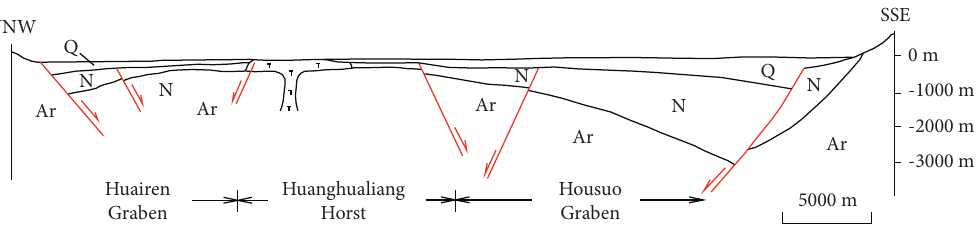
Figure 4: Geological section diagram of new rift of the Sanggan River, which contains Huairen Graben, Huanghualiang Horst, and Housou Graben, illustrating the geological structures of the study area. (Q) represents Quaternary strata, (N) represents Neogene strata, and (A) (r) represents Archean strata.